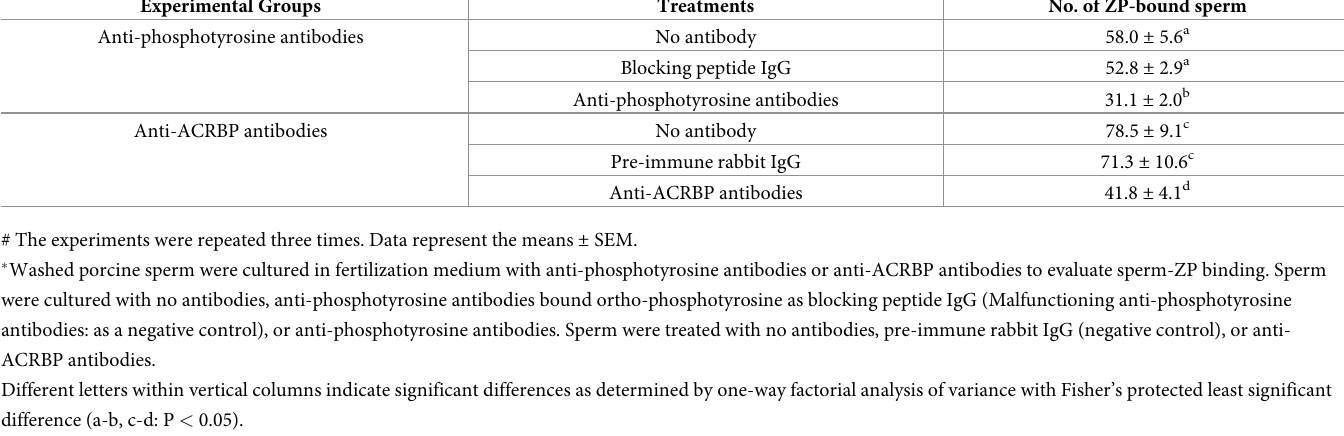
Table 1. Effect of anti-phosphotyrosine and anti-ACRBP antibodies upon sperm-ZP binding # . Experimental Groups